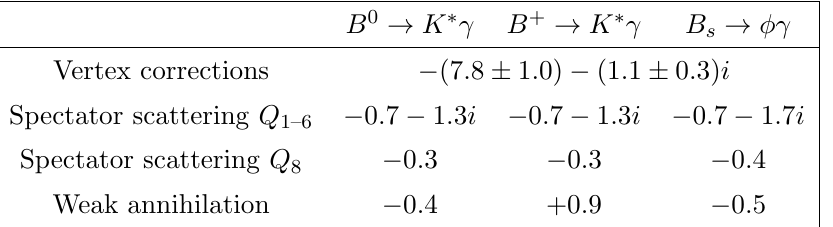
2 for the three decays. We only show the uncertainties Table 1 . Contributions to (cid:1) C 7 in units of 10 (cid:0) for the (numerically dominant) vertex corrections that are process